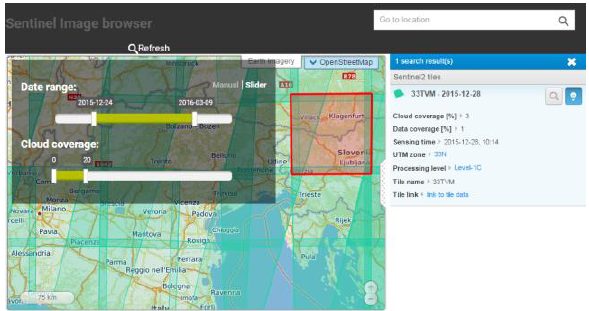
Figure 10: Sentinel Hub in